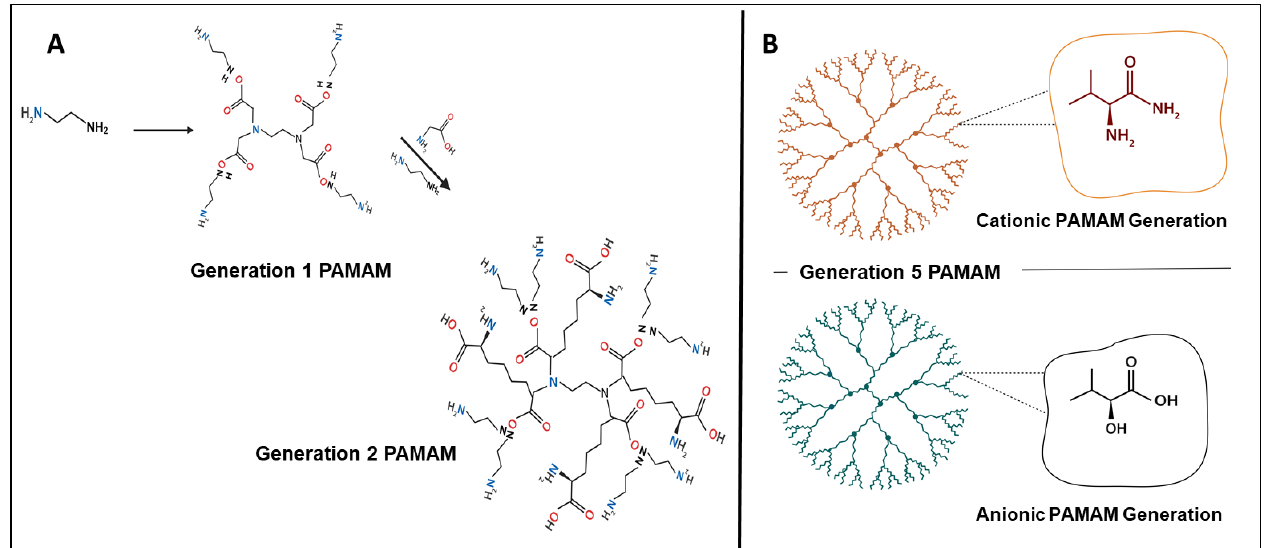
Figure 1. Schematic presentation of PAMAM dendrimer: ( A ) showing synthesis from G-0 to G-2, and ( B ) presenting G-5 PAMAM with cationic and anionic structures (Created with BioRender.com, accessed 6 December 2022).